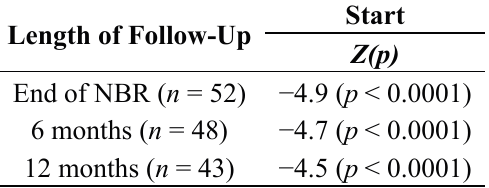
Table 3. Comparisons of the rank scores for BDI-II; comparing start of NBR with follow-up at the end of NBR and at six- and twelve-month follow-up, respectively. Length of Follow-Up